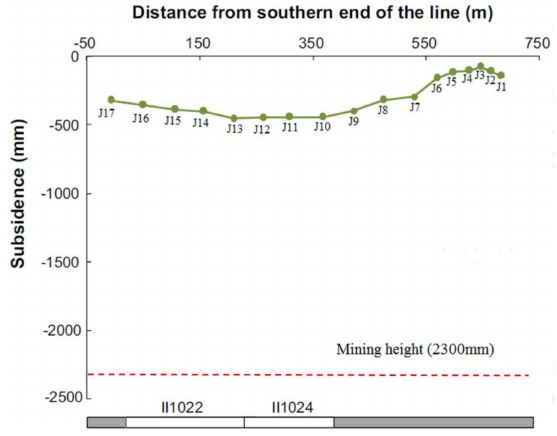
Figure 13. Investigation result of surface subsidence